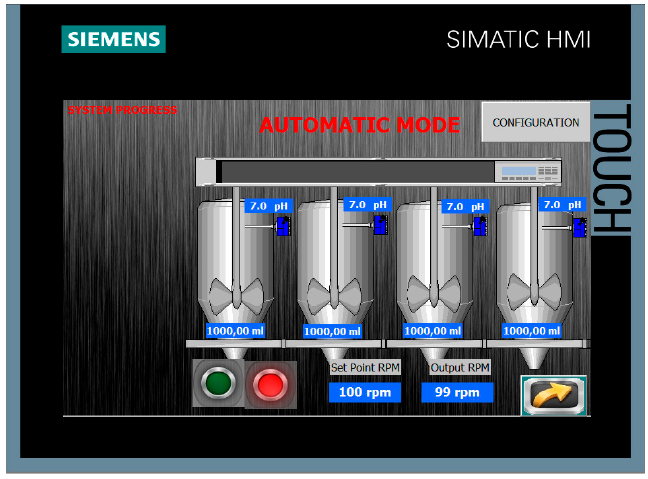
Figure 14. Screen of the HMI to illustrate the evolution of the JT.